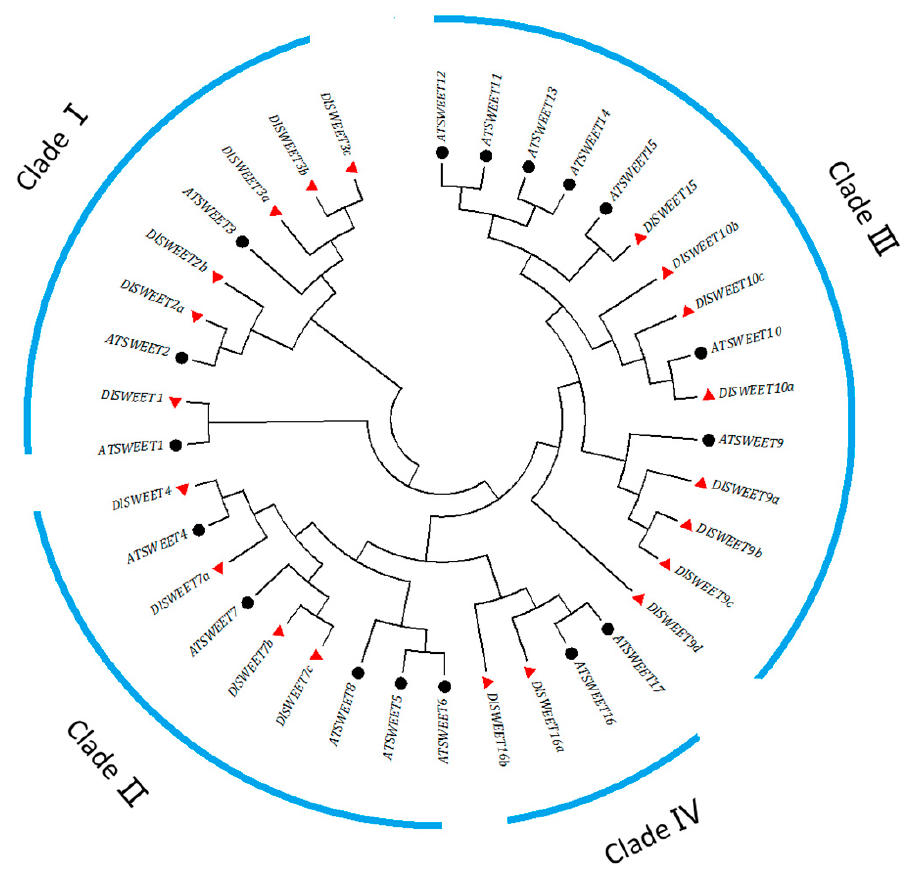
The evolutionary relationships of DlSWEET family members were assessed by con- structing an NJ phylogenetic tree (Figure 1). The results showed that DlSWEET proteins were clearly grouped into four different clades. Clade III is the largest groups, which contained eight DlSWEETs ( DlSWEET9a / 9b / 9c / 9d / 10a / 10b / 10c / 15 ), while clade IV had only two members ( DlSWEET16a / 16b ). Clades I and II contained six and four members, respectively.